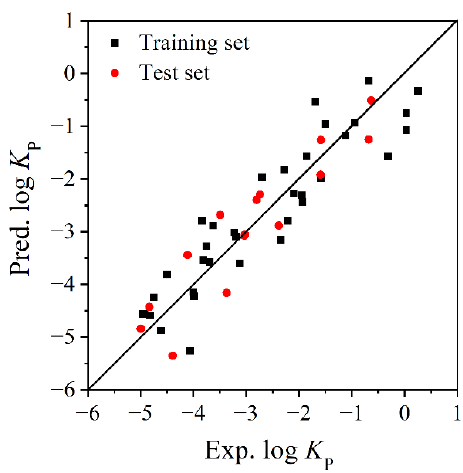
Figure 2. Fitting plot of experimental and predictive log K P values by MLR model.